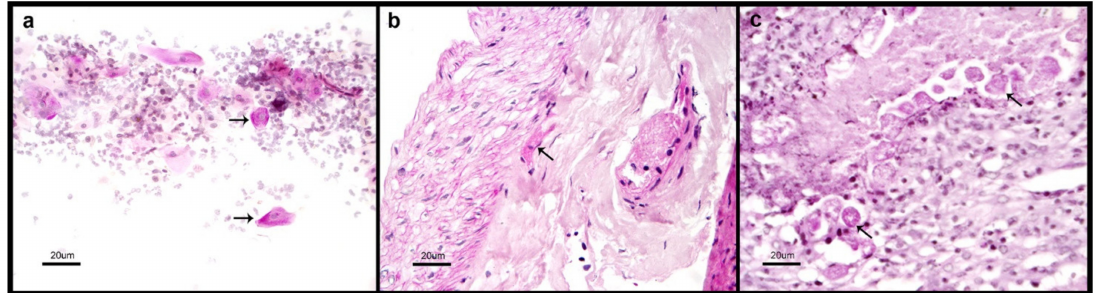
Figure 3. Microscopic identification of E. histolytica trophozoites. Biopsy specimens from patients with genital cutaneous amoebiasis histologically treated and stained with PAS, representative images; ( a ) a smear was performed directly over the slide; ( b , c ) samples from two di ff erent patients. The arrows point out some illustrative trophozoites. The scale bar represents 20 µ